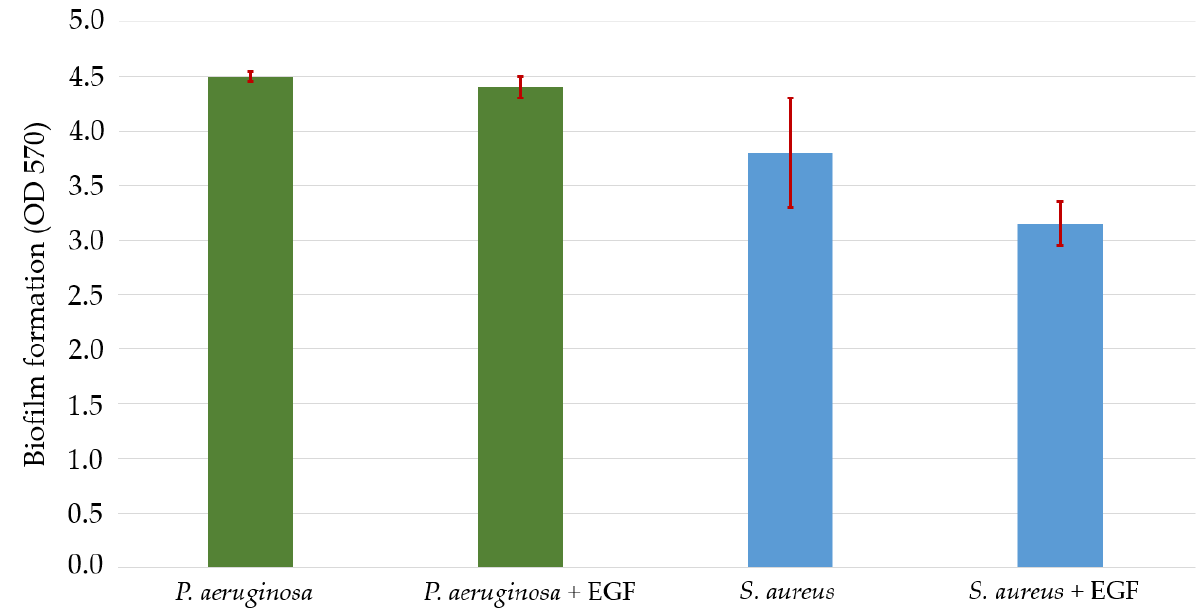
Figure 3. Growth of P. aeruginosa and S. aureus biofilms measured using spectrophotometry at a wavelength of 570 nm (OD570) in vitro. The error bars (highlighted in red) represent the standard deviation. Abbreviations: OD570: optical density measured at 570 nanometers; EGF: epidermal growth